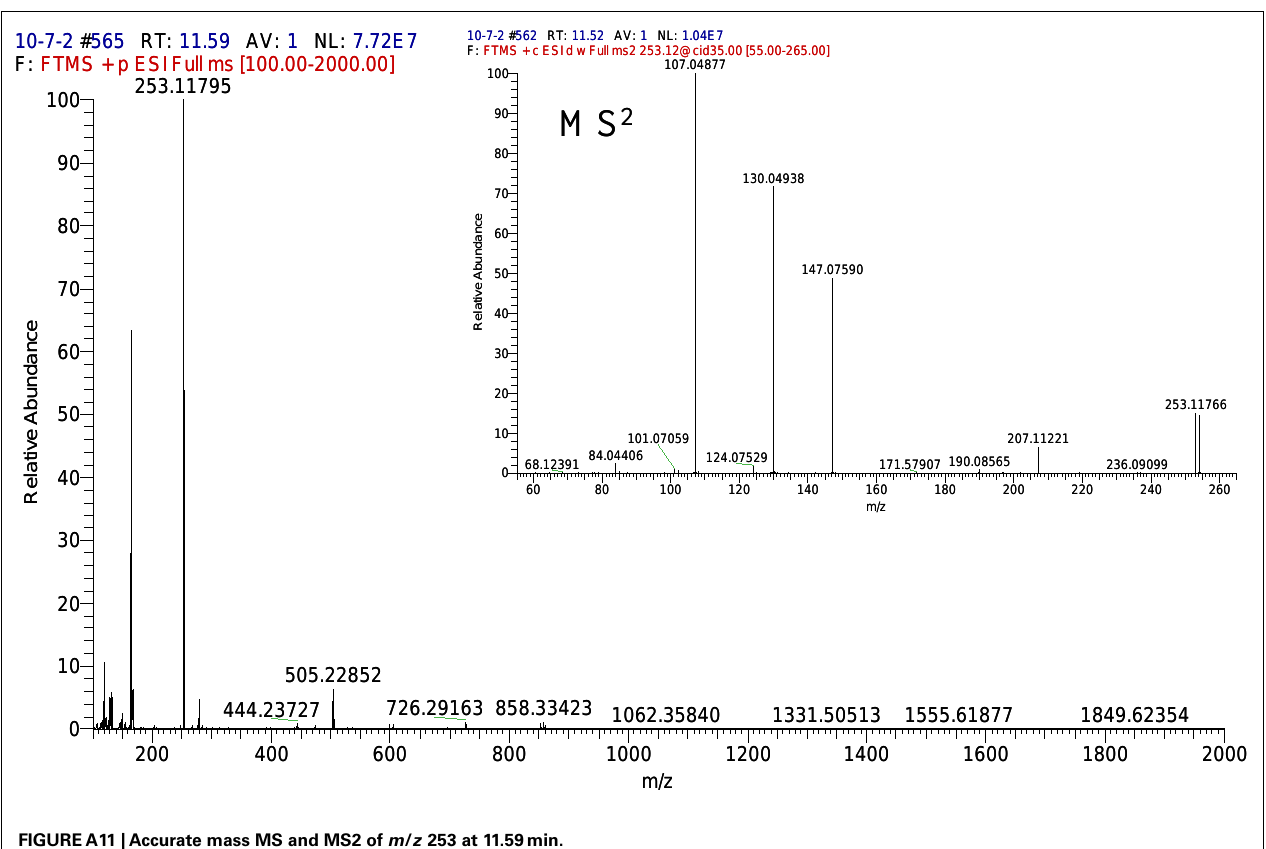
FIGUREA11 |Accurate mass MS and MS2 of m / z 253 at